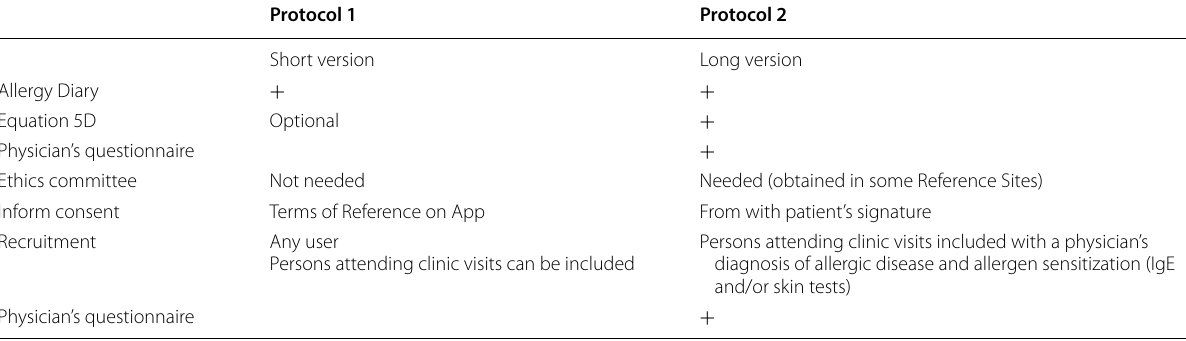
Table 3 Twinning protocols (from Bousquet et al.,